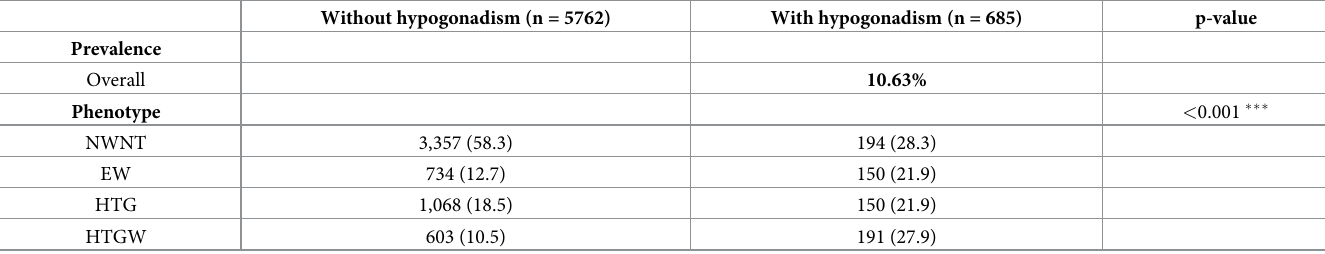
ism. In age group 1, participants with the HTGW (odds ratio [OR], 1.980; 95% confidence interval [CI], 1.354–2.896) and HTG phenotype (OR, 1.803; 95% CI, 1.297–2.505) had higher risks of hypogonadism than those with the NWNT phenotype, after adjustment for BMI, FBG levels, cholesterol levels, HDL levels, LDL levels and smoking status. In age group 2, partici- pants with the HTGW (OR, 1.873; 95% CI, 1.099–3.193) and HTG (OR, 2.098; 95% CI, 1.334– Table 2. Incidence of hypogonadism in the four phenotypes. Without hypogonadism (n =